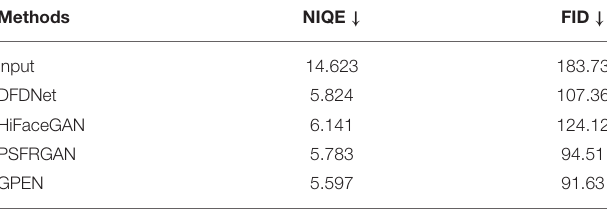
TABLE 7 | Quantitative comparison on the real-test.